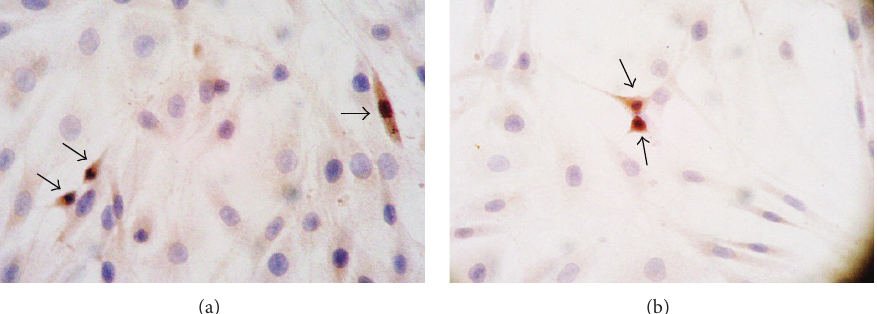
Figure 1: Determination of HSV1-TK and HSV1-sr39TK gene expression level in C6 cells by immunocytochemistry 48 hours after addition of DNA-liposome complex ( × 400). The percentages of TK positive cells in cultured C6-TK (a) and C6-sr39TK cells (b) were 13.25 ± 1.12 % and 13.76 ± 2.09 %, respectively ( 𝑃 > 0.05 ). Black arrow indicated immunostaining positive cells.